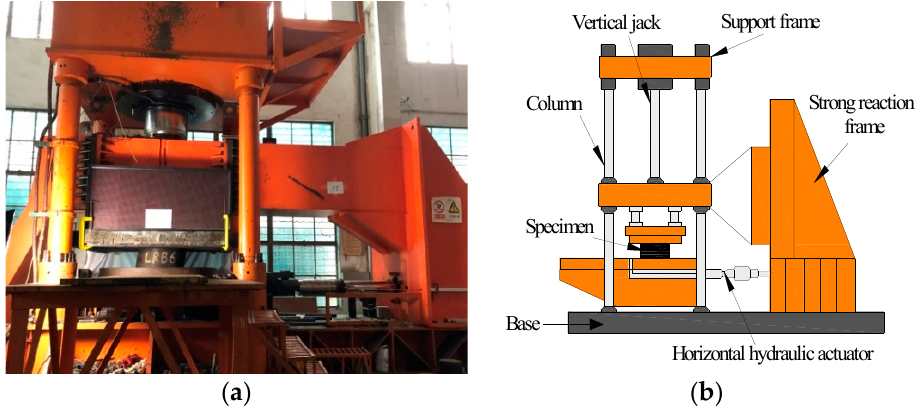
Figure 4. Compression‑shear loading testing machine: ( a ) photo; ( b ) components. Table 3. Test scenarios of the specimen